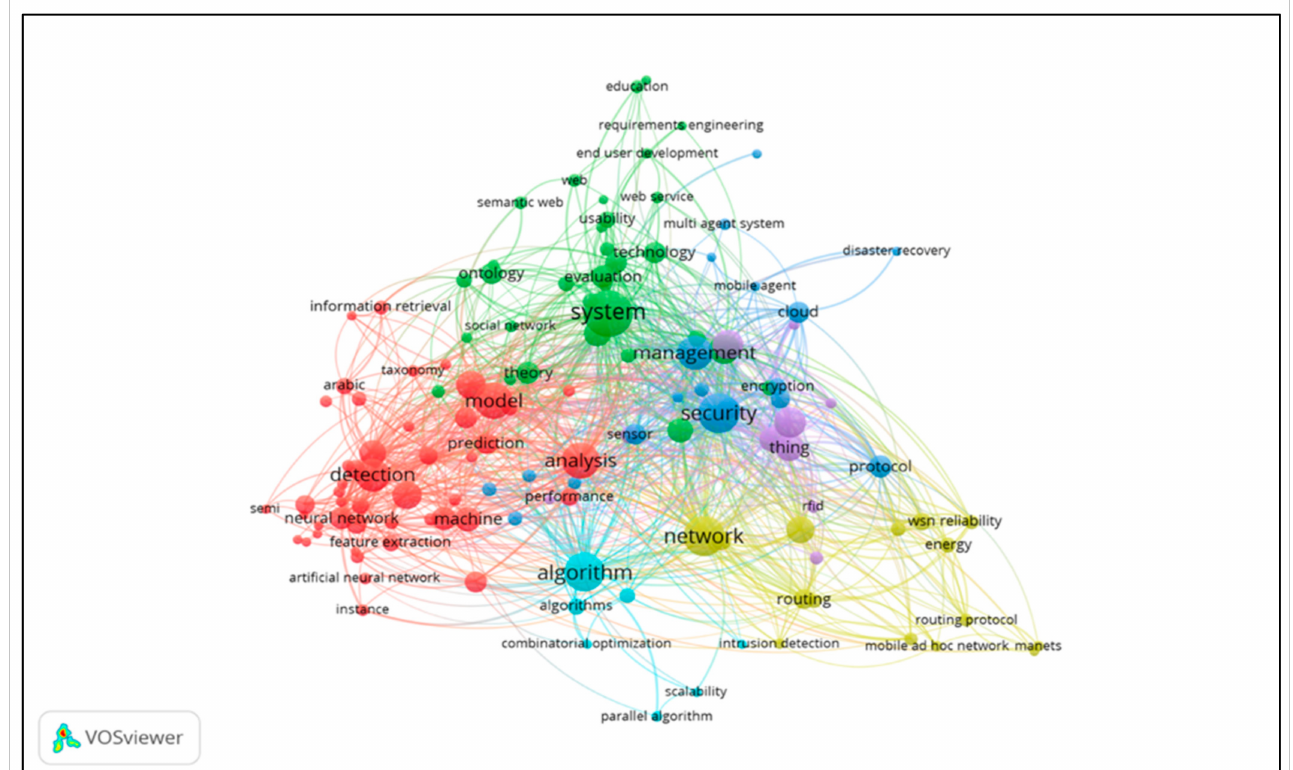
Figure 14. Co-occurrence keywords’